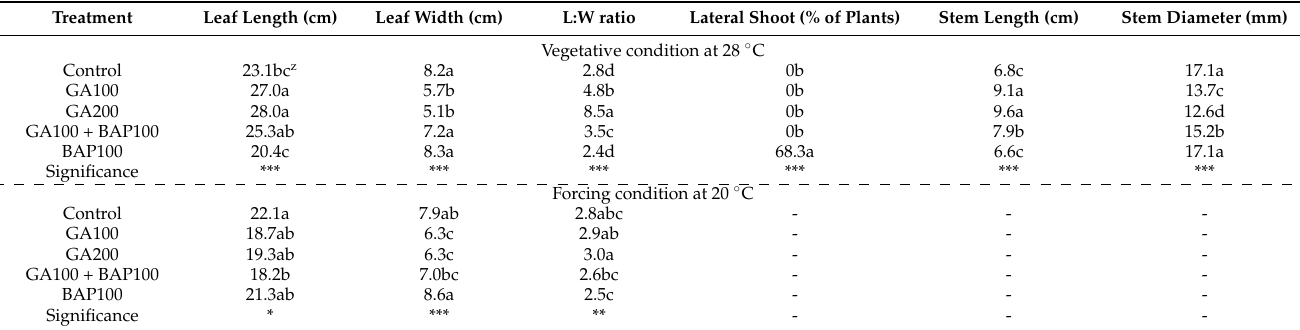
Table 1. Growth characteristics of Phalaenopsis Queen Beer ‘Mantefon’ treated with exogenous gibberellic acid 3 (GA 3 ) and 6-benzylaminopurine (BAP) at either 28 °C (vegetative condition) or 20 °C (forcing condition) for 15 weeks. Treatment